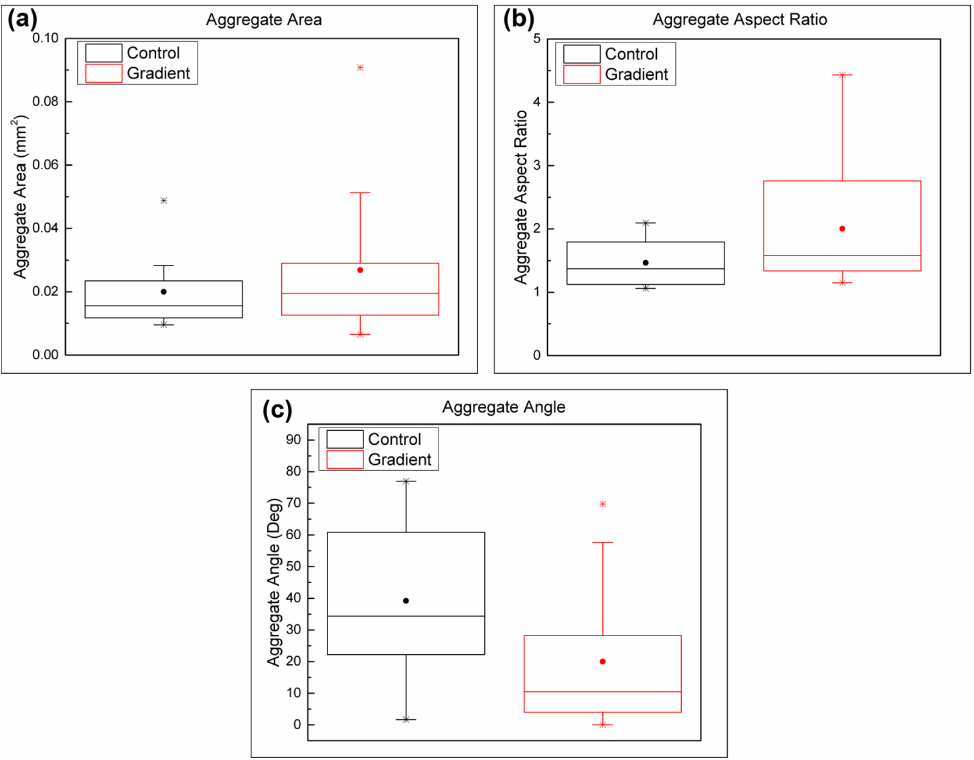
Figure 8. Effect of TGF- β 1 gradients on MSC aggregate properties. Box plots of ( a ) aggregate area ( p = 0.24), ( b ) aggregate aspect ratio ( p = 0.07), and ( c ) aggregate alignment angle ( p = 0.04). The alignment angle measurements for the gradient and control devices displayed a statistical difference with a p value less than 0.05 using the Mann-Whitney test. The box plot attributes are the same as that in Figure 4. N = 14 and N = 8 aggregates were used for the gradient and control devices respectively.